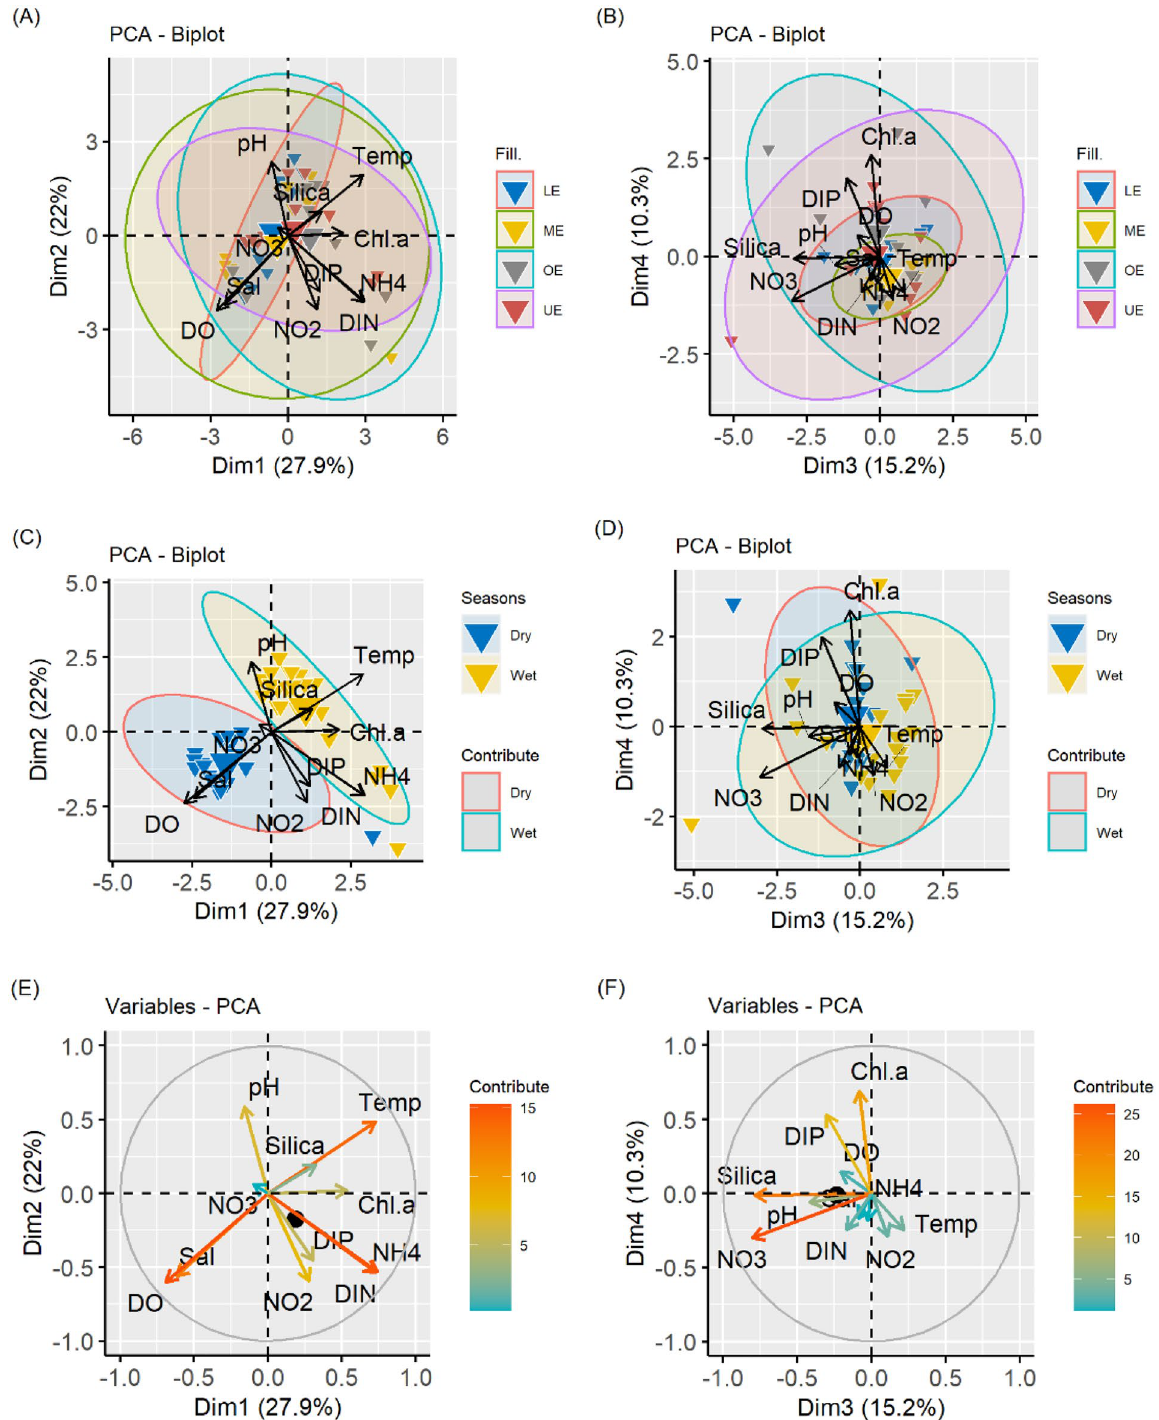
Figure 8. Factorial plan of the first, second, third and fourth axes of the principal component analysis (PCA) for the spatial ( A , B ), temporal ( C , D , E , F ) environmental parameter of the lower Meghna River estuary (UE = Upper estuary, ME = Middle estuary, LE = lower estuary, CK = Char Kukrimukri, HI = Hatiya and eutrophic and coastal upwelling regions 59,60 . This scenario is true for most of the Indian mangroves; how- ever, some mangroves have nitrate as the major DIN pool. The dominant DIN pool varies depending on source, processing, and other environmental factors. High river discharge and runoff plays a key role in bringing these nutrients (DIN and NH 4+ ) to this system during the wet season. Temporally, the impact of DIN and NH 4+ on the phytoplankton biomass production were greater in the wet season than in the dry season (Fig. 8). In addition,